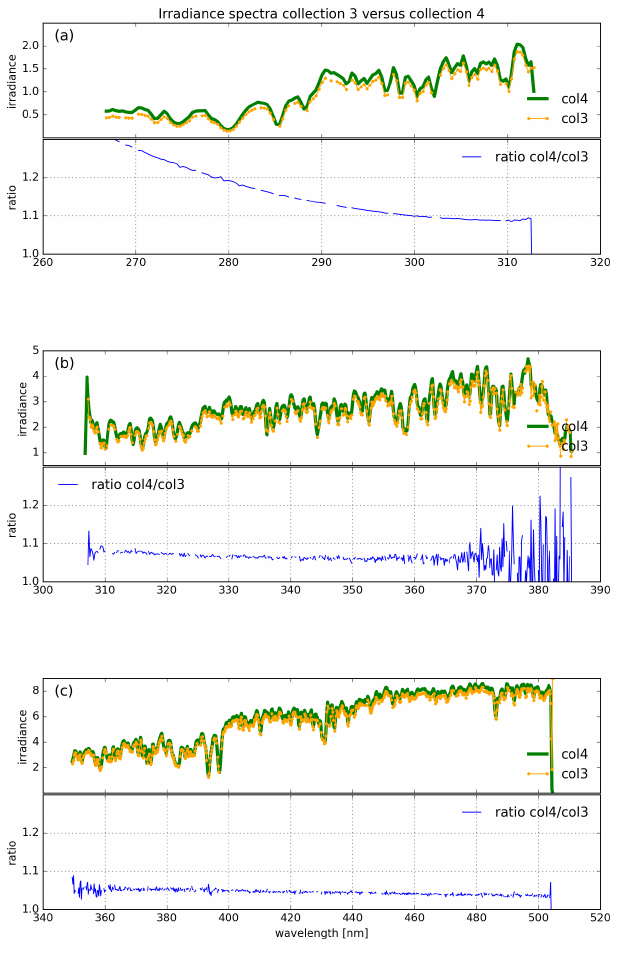
Figure 22. Comparison of the irradiance spectra between collec- tion 4 and collection 3 for the UV1 (a) , UV2 (b) , and VIS (c) chan- nels. In each panel the top plot shows both absolute values and the lower plot shows the ratio between the two collections, as observed late in the mission for orbit 88854.